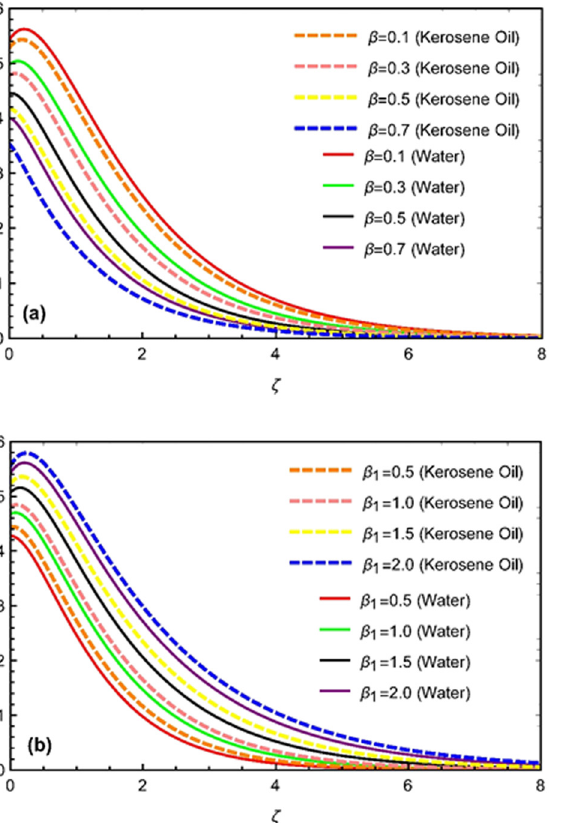
Figure 5: ( a and b ) Change in velocity for ( a ) hear Grashof number Gr and ( b ) mass Grashof number Gm for velocity fi eld with β = 0.5, Pr = 5.6, Sc = 3.9. t = 1.3, φ = 0.03.